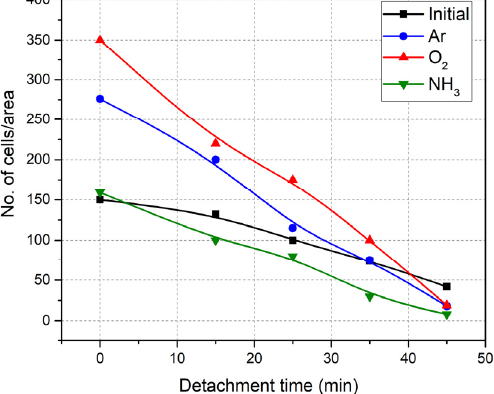
Figure 12. Number of cells present on the surface as a function of cooling time, from 37 °C to 22 °C, for the initial and plasma-treated pNIPAAM surfaces.